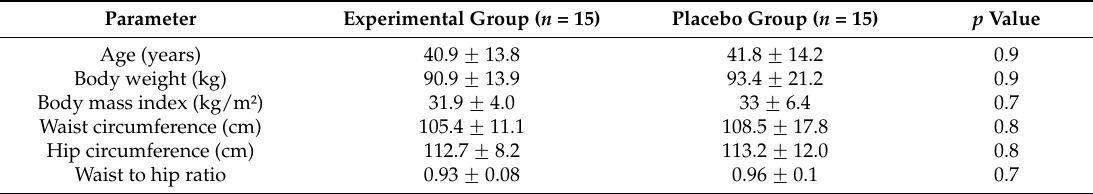
Table 1. Baseline physical characteristics of the participants at randomization.